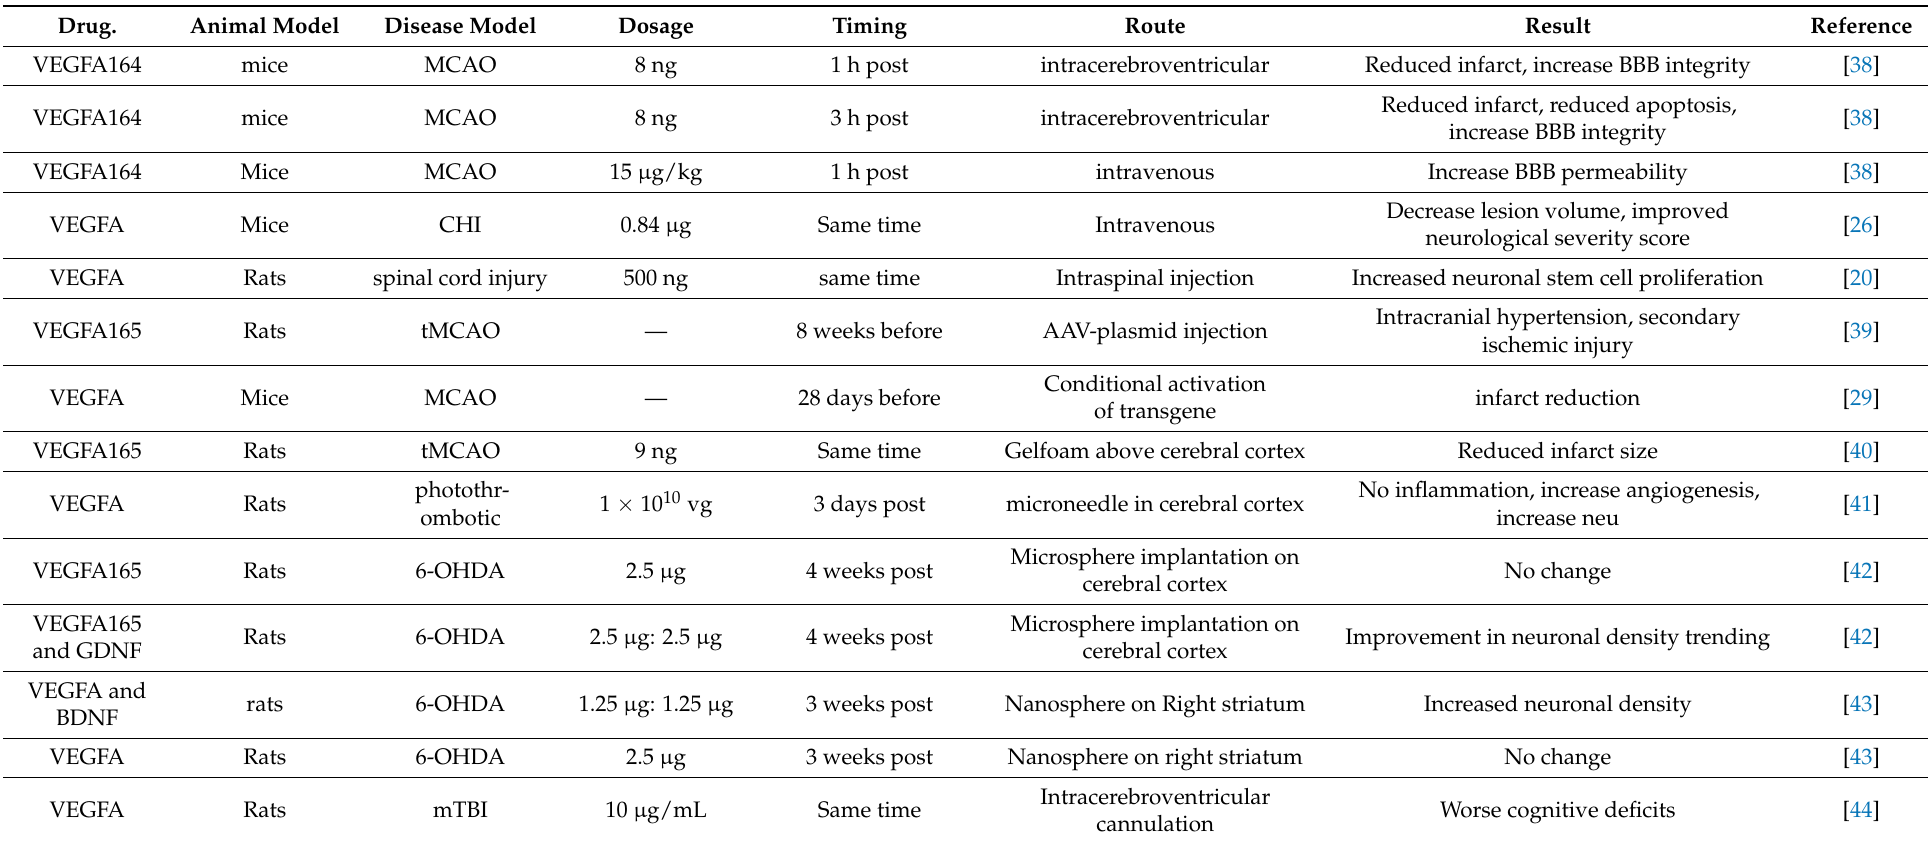
Table 1. Varying effects of VEGFA pro-angiogenic therapy in animal models. Experimental results of treatment with VEGFA or its isoforms in different disease and animal models lead to an array of different findings. MCAO: Middle Cerebral Artery Occlusion. tMCAO: transient MCAO. BBB: blood–brain barrier.